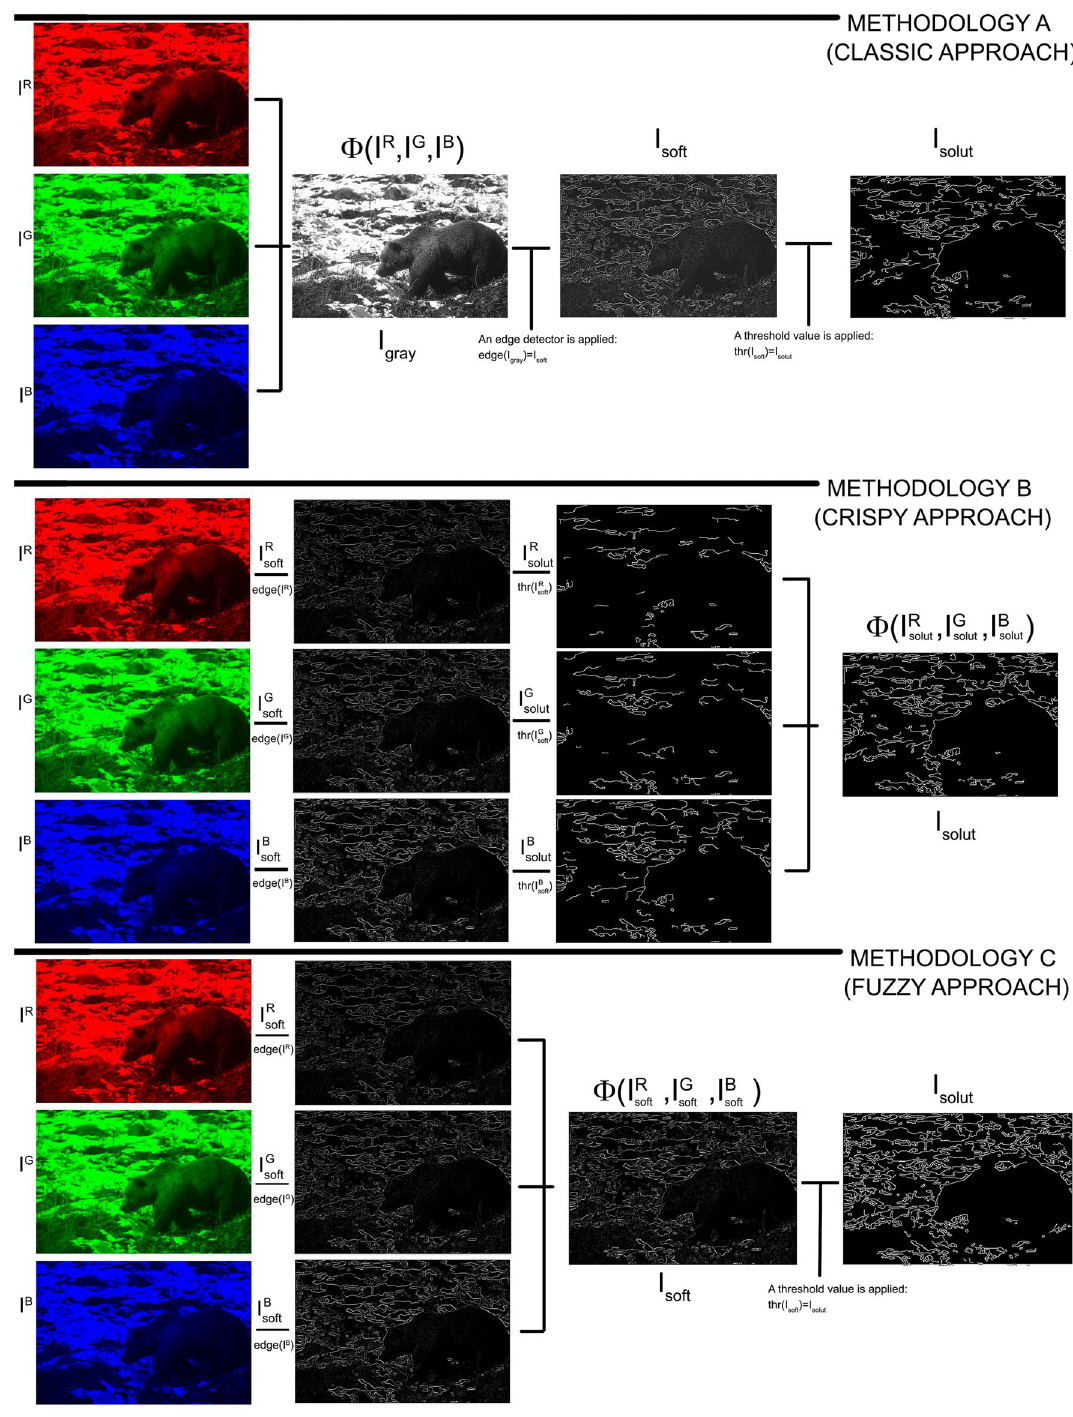
Fig. 2 Scheme of methods A, B and C with RGB